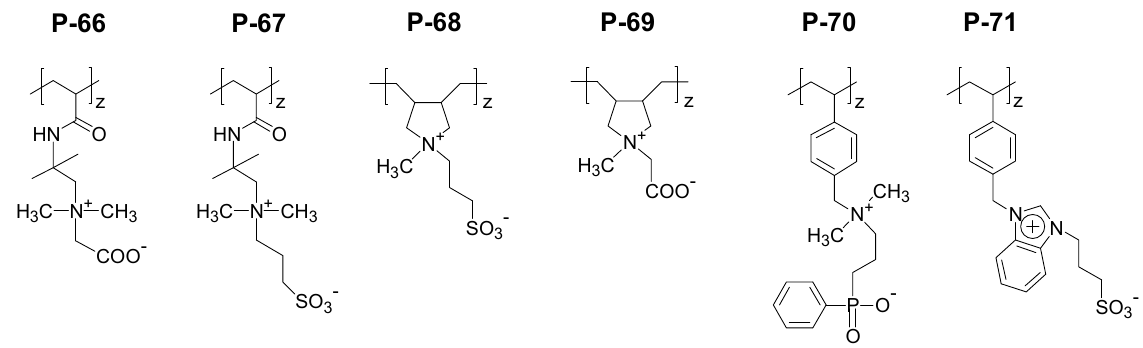
Figure 16. Examples of permanent polyzwitterions with improved resistance to hydrolysis compared to (meth)acrylic polymers: sterically hindered polyacrylamides P-66 and P-67 [429,430], diallylammonium polymers P-68 and P-69 [87,88,431], and polystyrenes P-70 and P-71